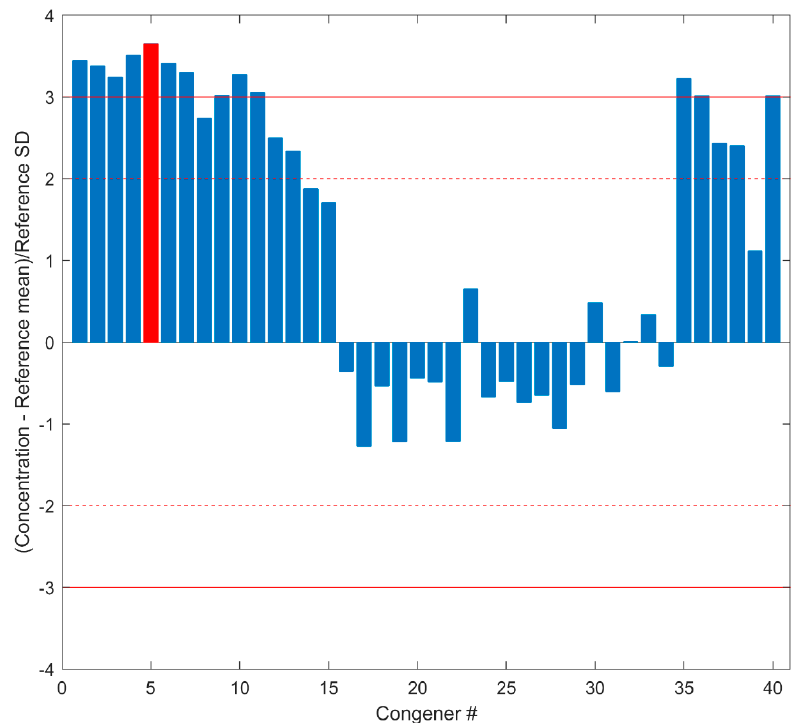
Figure 5. Concentrations of congeners in Spike Data. The differences in concentrations of the 40 congeners between Spike Data and corresponding mean concentrations in Spike Reference are transformed by standardization scaling to the standard deviations calculated from Spike Reference and are plotted at the y axis. The x axis indicates the congener numbers that are given in Supplementary Table S1. The dashed lines give the region within two standard deviations, and the solid lines depict the region within three standard deviations. The red bar represents the scaled concentration of congener 1234789-HpCDF.